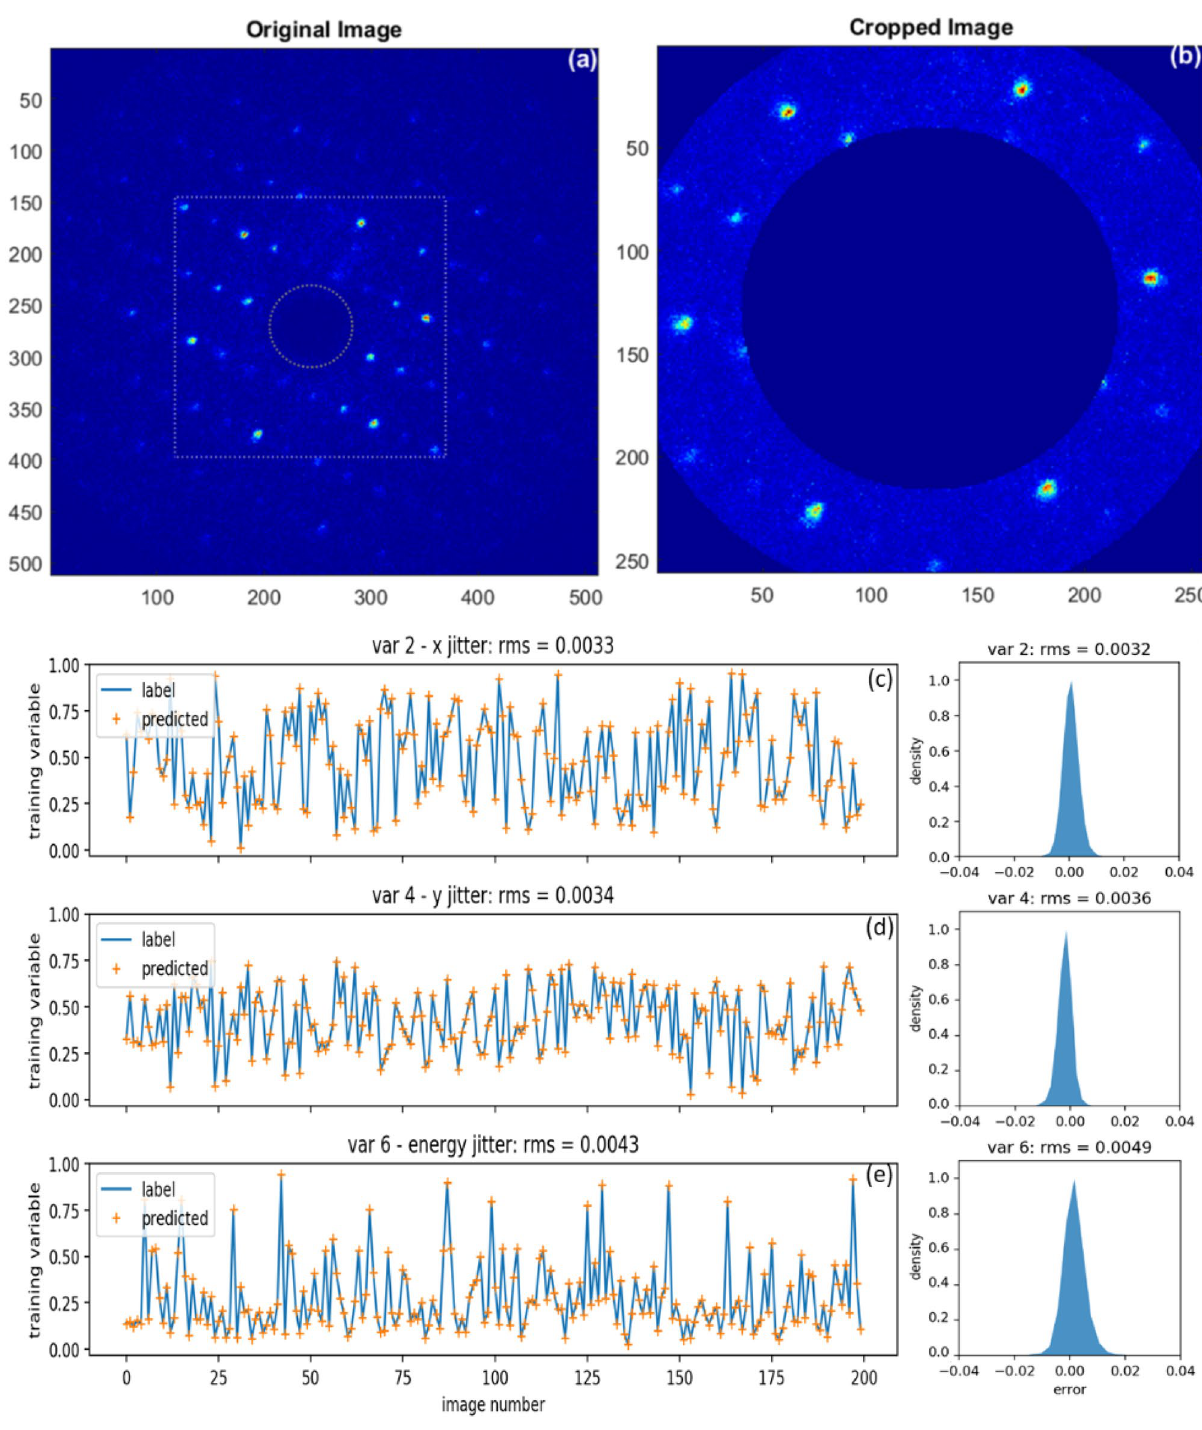
Figure 5. An example of original experimental image ( a ). The white box indicates the selected area for the data analysis. The dashed circle represents the hole of the mirror in the detector system. Cropped image for the ML ( b ). Training variables 2 ( c ), 4 ( d ), and 6 ( e ) via the data analysis using the Gaussian method are plotted as the blue curve while their corresponding predictions as the result of the ML model are plotted as the orange crosses respectively for the untrained two hundred images. Besides, their corresponding error distributions for the entire dataset of ten thousand images are plotted on the right side. The RMS errors for the untrained images and the entire dataset agree extremely